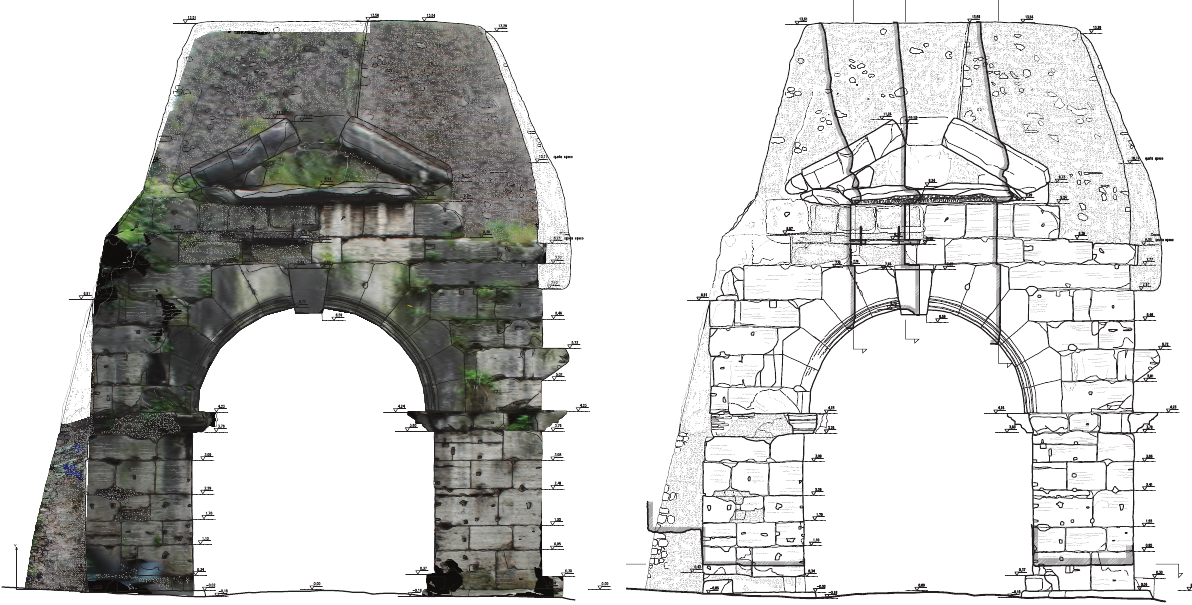
13. Restitution of North façade with photo textures Figure 14. Restitution of North façade with sections in